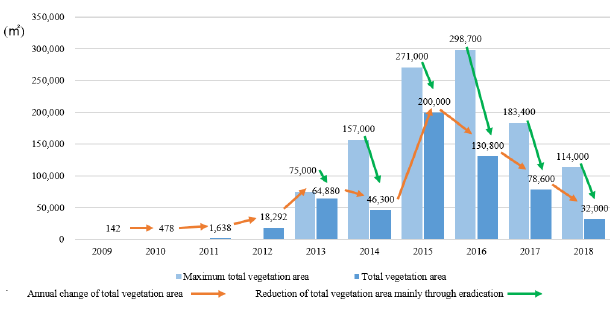
Fig. 3 . Total vegetation area of Ludwigia grandiflora in Lake Biwa. (Data: Lake Biwa Special Council for Invasive Aquatic Plants, Shiga